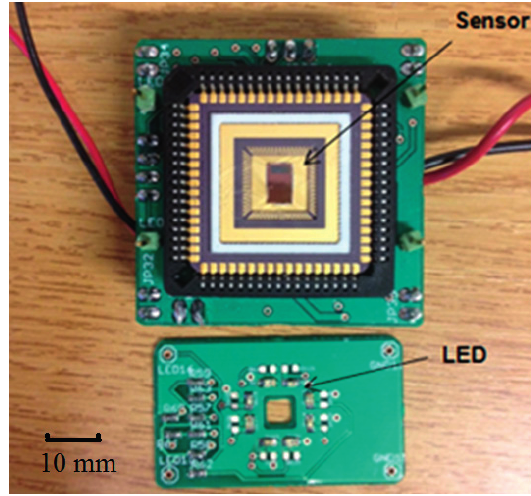
Figure 2. CMOS Sensor chip and LED illumination